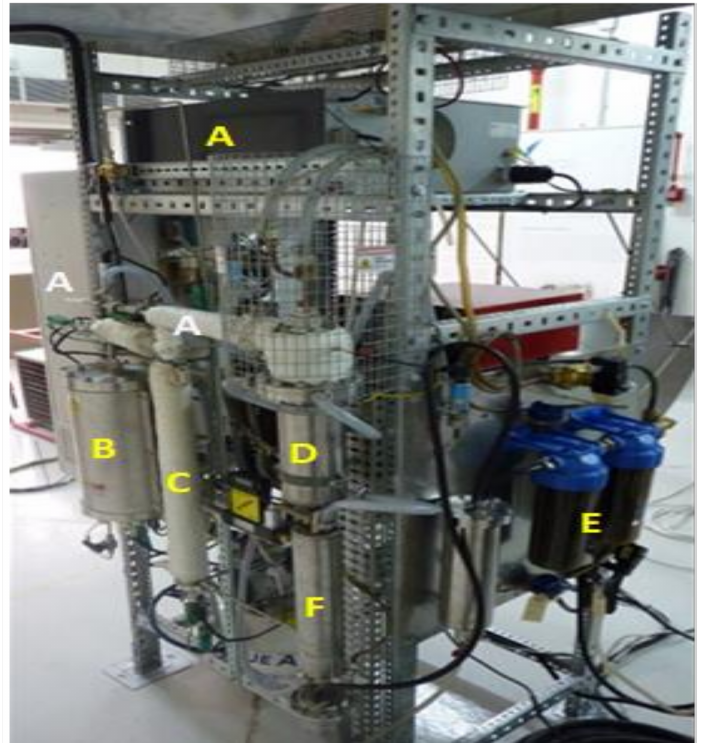
Figure 2. View of the test bench showing the following components: ( A ) power supply; ( B ) steam generator; ( C ) air heater; ( D ) reactor; ( E ) gas filters; ( F ) cooler.